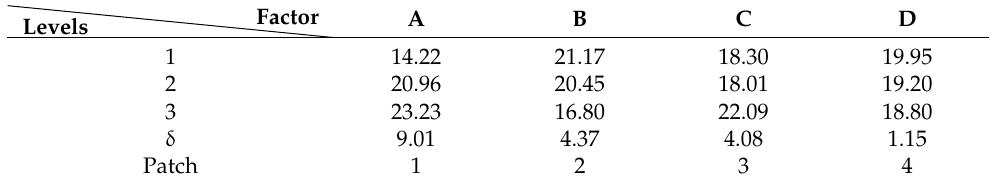
Table 5. Scratch width average analysis.